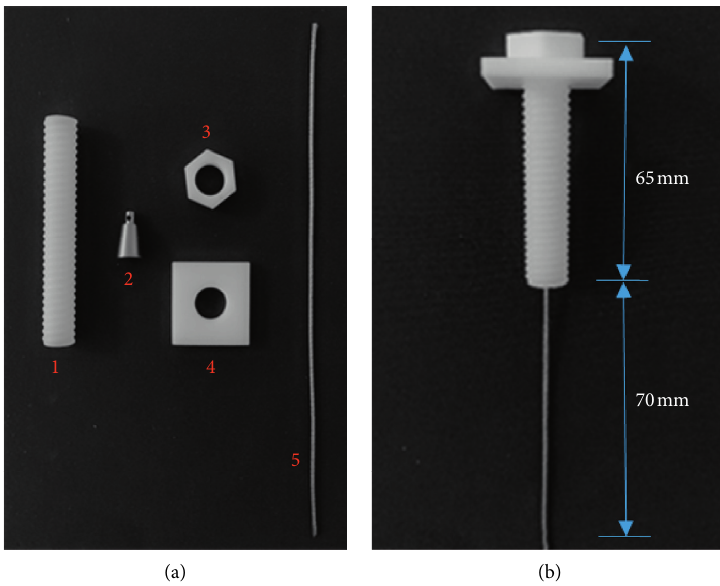
Figure 9: NPR bolt model: (a) bolt components; (b) NPR bolt